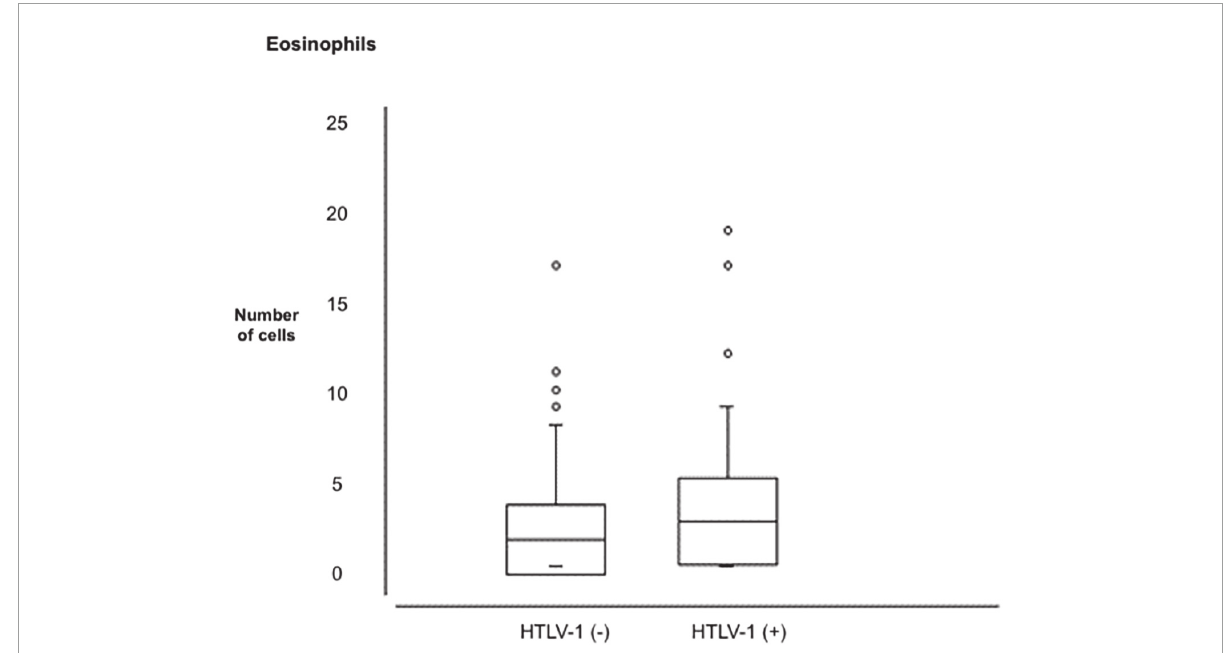
FIGURE1 Distribution of eosinophils in patients negative and positive for the human T-lymphotropic virus type 1 (HTLV-1).